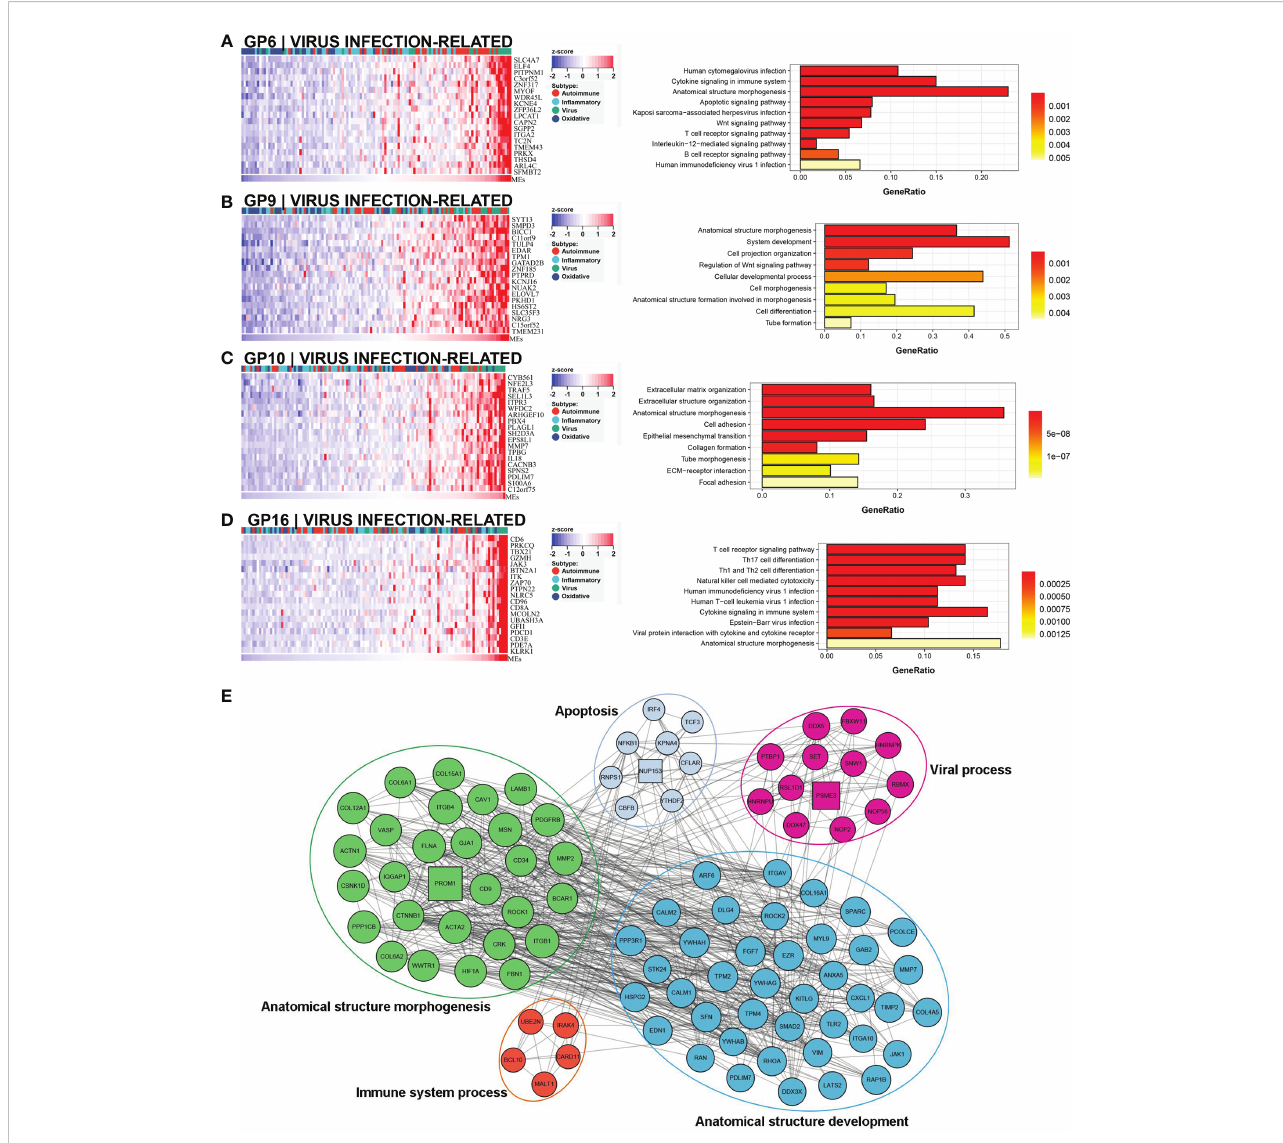
FIGURE 6 Core GP de fi ning the virus infection-related subtype. The biological processes of GP6 revealed cytomegalovirus infection and immune process (A) . GP9 revealed biological processes of anatomical morphogenesis (B) . GP10 showed fi brosis-related processes of EMT and ECM (C) . The main biological processes of GP16 were virus infection and immune process (D) . The protein-protein interaction network of representative genes of virus infection- related subtype revealed the enriched biological processes (E) . EMT, epithelial-mesenchymal transition; ECM, extracellular